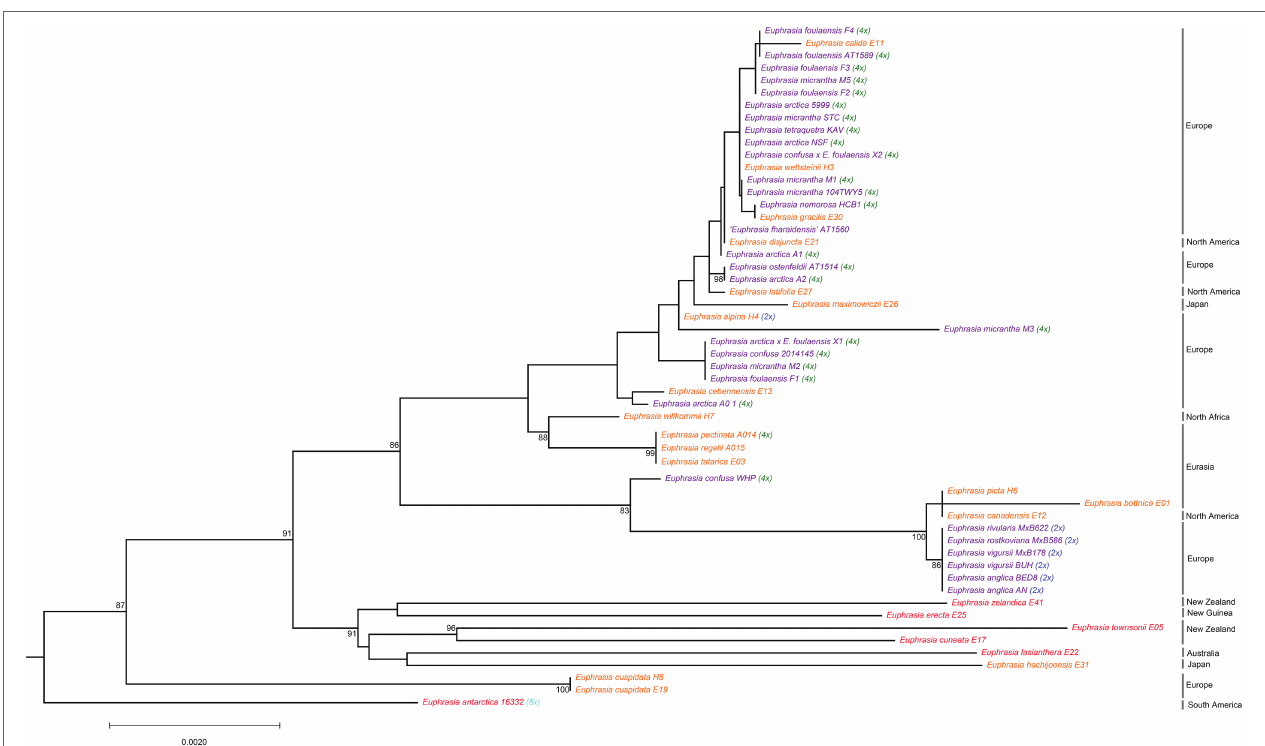
FIGURE 2 | Phylogenetic relationships inferred from nrDNA sequences for global Euphrasia species. Phylogeny constructed based on an alignment of 5,845 sites, using a maximum likelihood analysis implemented in IQTree 2. Branches labeled with bootstrap support values over 85%. Phylogeny rooted on Bartsia , which is removed here for better visualization. Tip labels are colored and labeled by ploidy, as Figure 1